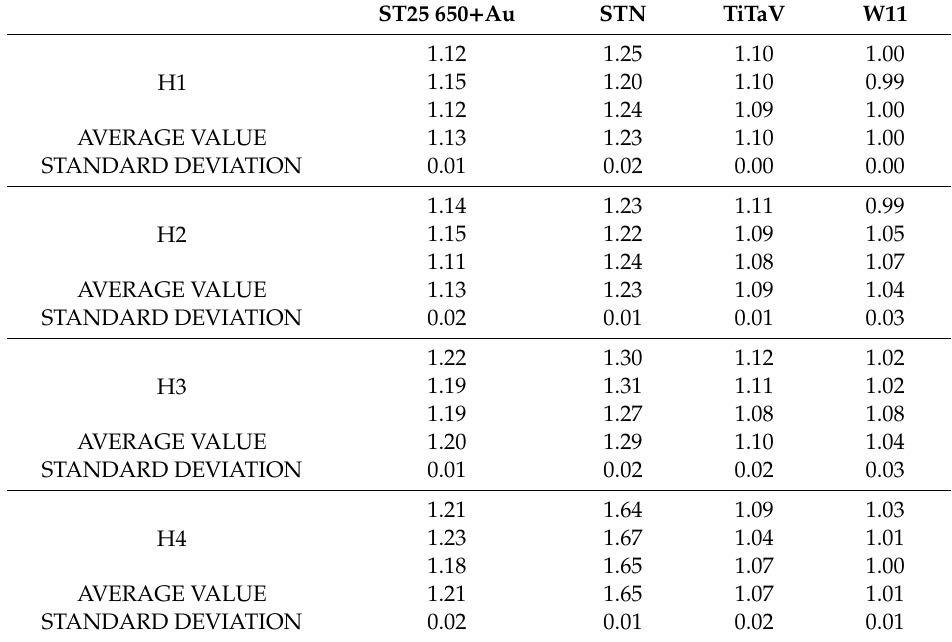
Table 5. Data, average values, and standard deviations from blood tests on healthy samples shown in Figure